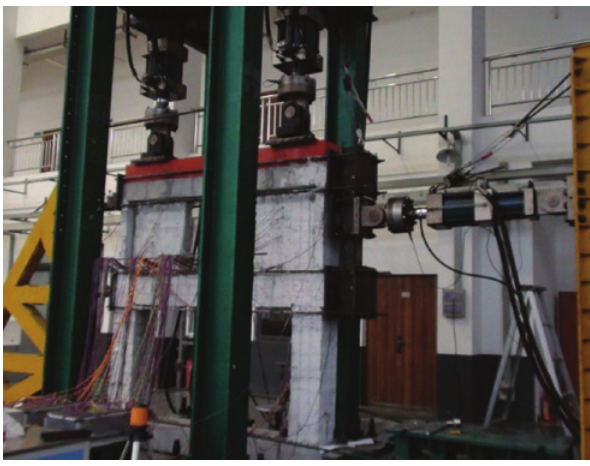
Figure 3: The actual loading equipment.